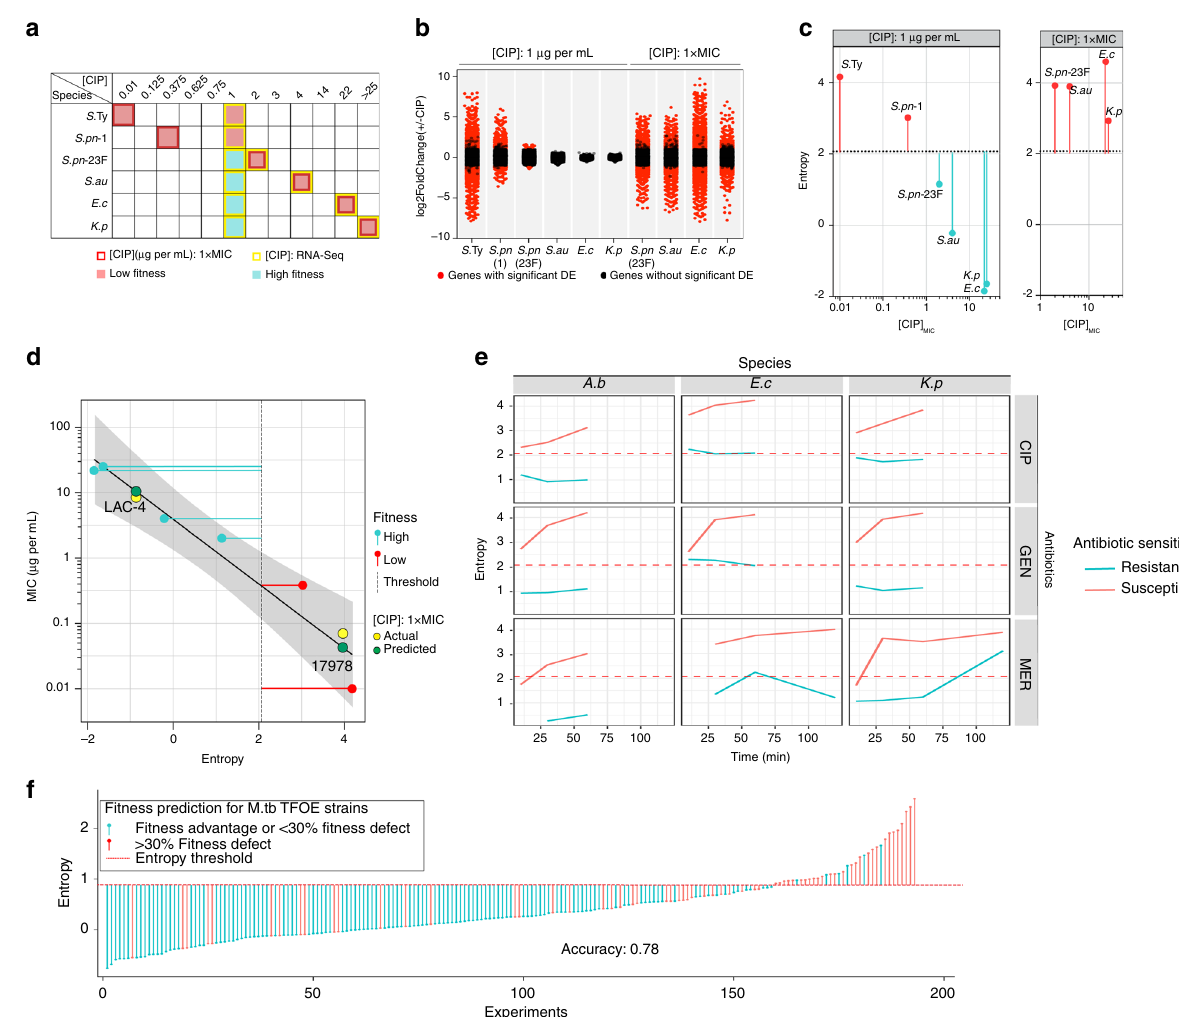
Fig. 5 Entropy-based predictions extend to multiple species under antibiotic or regulatory stress. a Six strains representing fi ve species are ranked from low to high cipro fl oxacin minimal inhibitory concentrations (MIC CIP ) tested by growth curve assays (Supplementary Fig. 1). The multi-species CIP RNA-Seq is performed at two CIP concentrations: (1) 1 µ g per mL for all six strains corresponding to two low fi tness outcomes (red squares) and four high fi tness outcomes (cyan squares); (2) MIC CIP for strains that are insensitive to 1 µ g per mL of CIP, i.e., S. pneumoniae serotype 23F, S. aureus UCSD Mn6, E. coli AR538, and K. pneumoniae AR497, corresponding to four additional low fi tness outcomes. The number of genes that change in expression upon exposure to 1 µ g per mL CIP (|log2FoldChange| > 1 and p -adj < 0.05) as well as their change in magnitude is inversely correlated to their CIP sensitivity ( b ) and their entropy ( c ). In addition, strains with MIC CIP higher than 1 µ g per mL revert to triggering a large number of differential expression genes ( b ) and a high entropy ( c ) at their respective 1× MIC CIP . d Using a linear regression model (black line; error band: 95% con fi dence interval for the regression), MIC ’ s are predicted for A. baumannii strains ATCC 17978 and LAC-4 based on their entropy at 1 µ g per mL of cipro fl oxacin. The predicted (green datapoint) and measured (yellow datapoint) MIC for the two strains are highly accurate indicating that entropy can be used as a quantitative predictor. See Supplementary Fig. 1D for MIC determination for A. baumannii ATCC17978 and LAC-4. e Further validation of the generalizability of the single time-point entropy approach on published expression data 11 . The universal entropy threshold of 2.08 trained on our S. pneumoniae data, was successfully used to predict fi tness outcomes of susceptible and resistant strains from three species in the presence of three different antibiotics. Importantly, six of the species-antibiotic combinations (GEN- A.b / E.c / K.p and MER- A.b / E.c / K.p ) were not present in our datasets, which highlights the universality and generalizability of the entropy based approach. GEN gentamicin, MER meropenem. A.b A. baumannii, E.c E.coli, K.p K. pneumoniae . f Entropy calculated from transcriptional pro fi les of 193 M. tuberculosis transcription factor overexpression (TFOE) strains from reference 35 separates strains with a >30% fi tness defect upon TFOE induction (red) from strains with a fi tness advantage or <30% fi tness defect upon induction (cyan). At the threshold of 0.71 (red dotted line), fi tness outcomes are correctly predicted at an accuracy of performance than a gene-panel based approach (Supplementary because it turns out that the genes that appear in these panels are Data 6), and has at least three additional advantages over existing strongly in fl uenced by model parameters ( λ ) and input data gene-panel approaches: (a) It is independent of speci fi c genes, (Fig. 1). (b) An entropy-based method has few (at most 2) whereas gene-panels focus entirely on speci fi c genes. This might parameters, and therefore does not risk over fi tting (unlike gene- lead researchers to interpret genes present in a particular panel as based approaches, where there is at least one parameter per each those most relevant to the stress response. However, caution transcriptionally measured gene). (c) The entropy method gen- should be taken in the interpretation of these gene panels, eralizes across different antibiotic and non-antibiotic conditions,